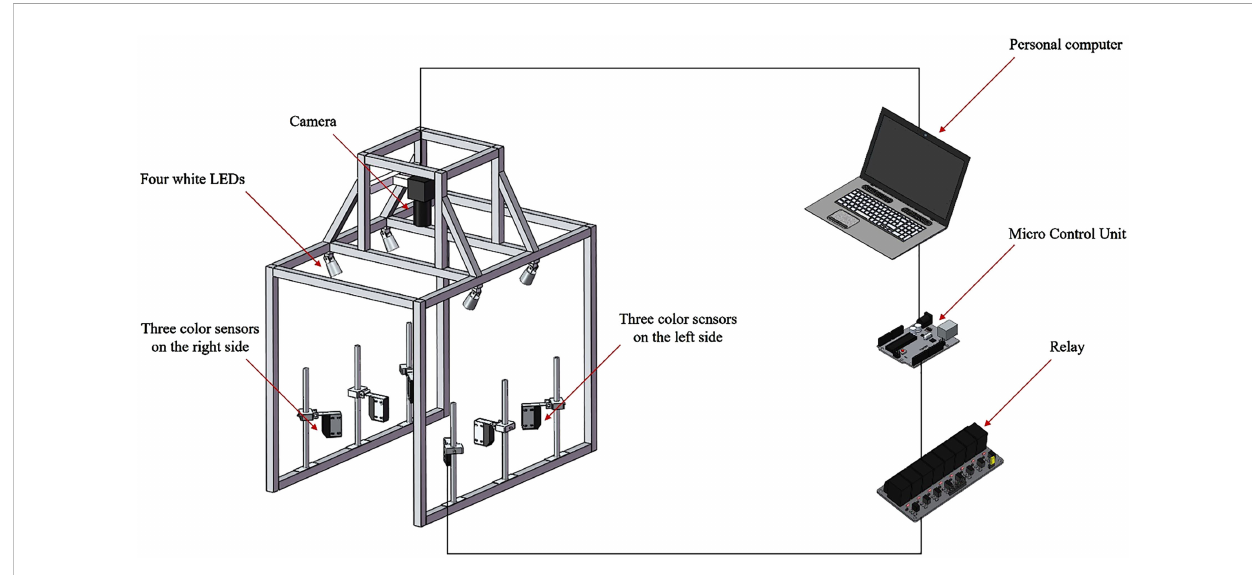
FIGURE 4 The mechanical structure of the detection